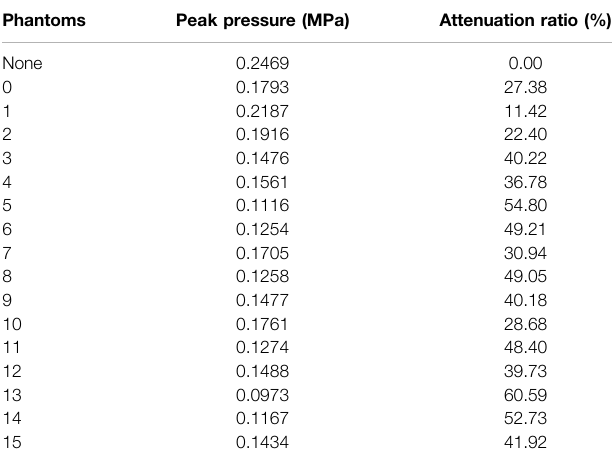
TABLE 2 | Peak pressure of transmitted ultrasound energy in sixteen 3D printed skull phantom. Phantoms Peak pressure (MPa) Attenuation ratio (%)